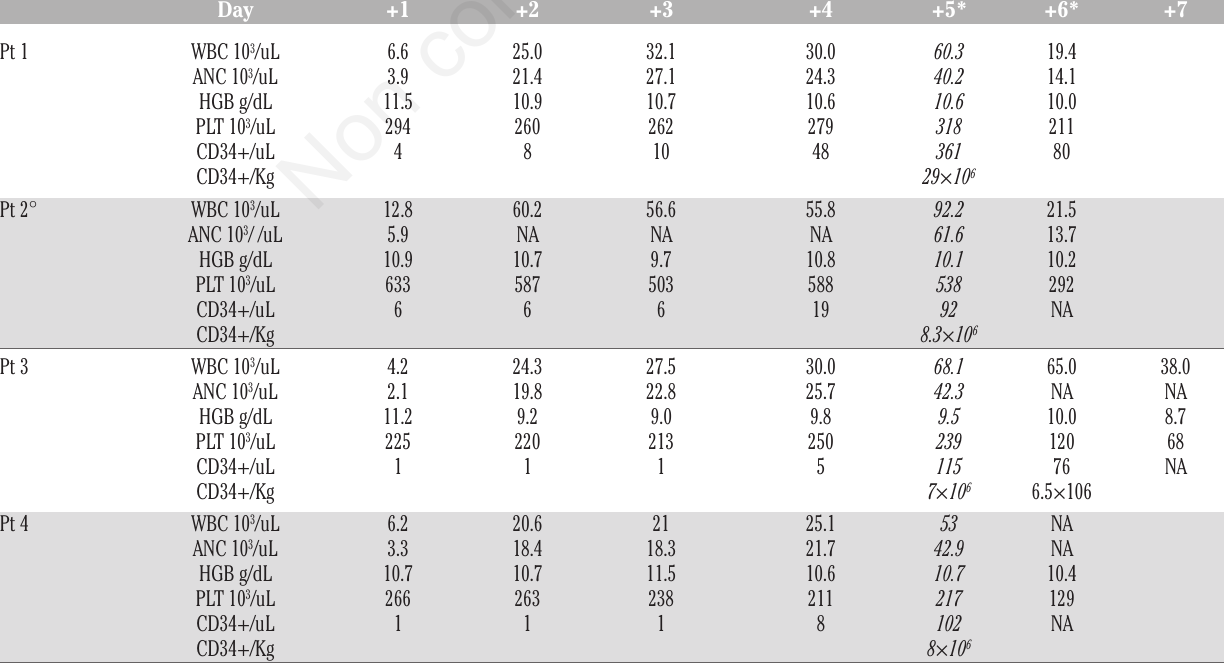
Table 3. Blood CD34+ cell counts and hematological parameters during G-CSF+plerixafor mobilization.